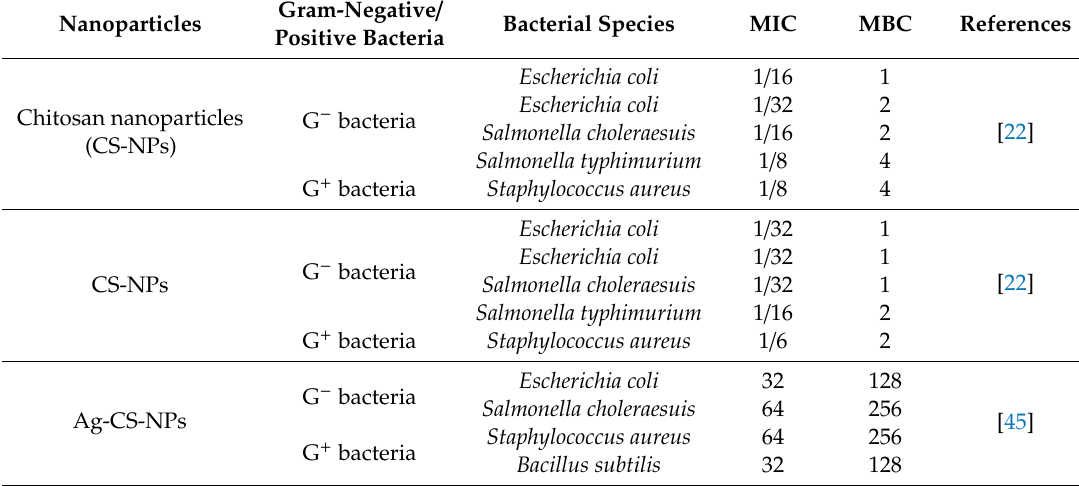
Table 2. Minimum inhibitory concentration (MIC) ( µ g / mL) and minimum bactericidal concentration (MBC) ( µ g / mL) values of chitosan nanoparticles and their derivatives against gram-negative (G − ) and gram-positive (G + )